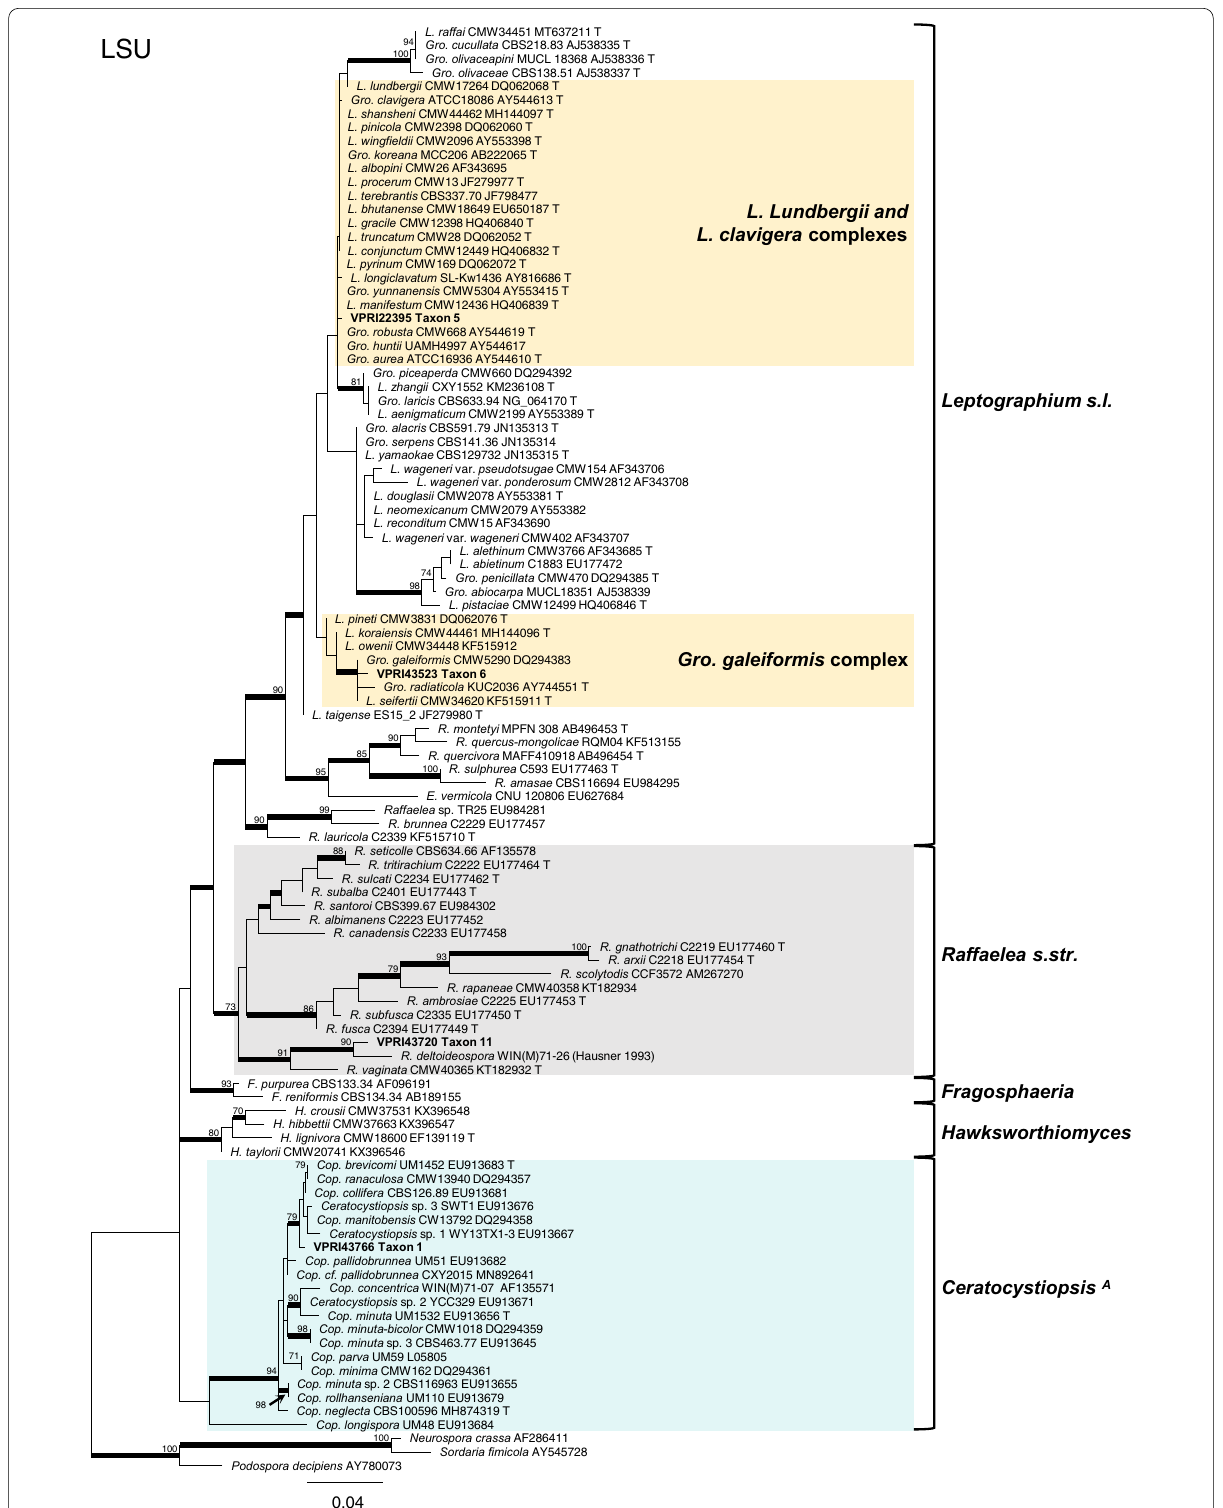
Fig. 2 ML phylogeny of LSU region for isolates residing in Ceratocystiopsis , Leptographium s. lat . and Raffaelea . Sequences generated in this study are printed in bold. Bold branches indicate posterior probability values cultures. A Taxon names as described by de Beer and Wingfield